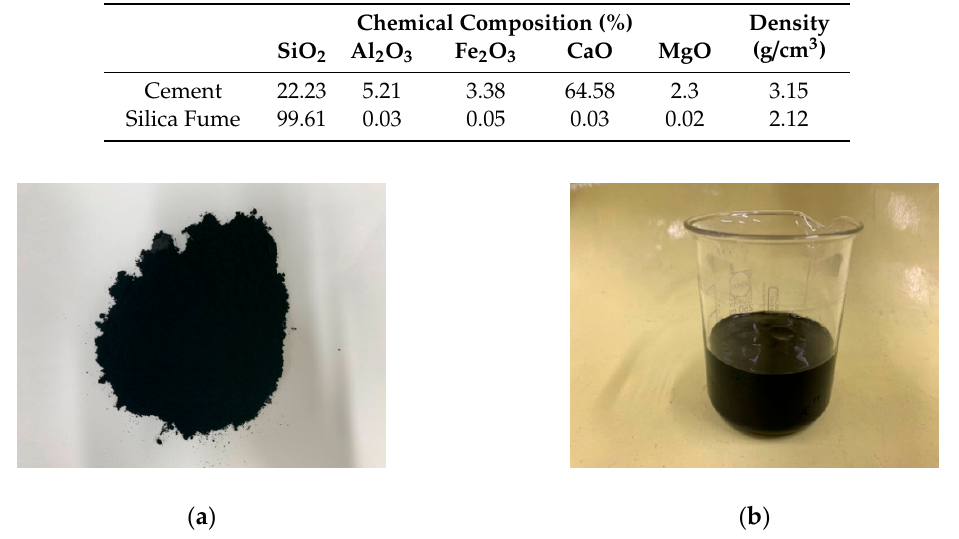
Figure 1. Pictures of ( a ) powder type and ( b ) liquid type multi-wall carbon nanotubes. Table 2. Composition of liquid multi-wall carbon nanotubes (MWCNTs) (mass fraction). Table 1. Chemical compositions and densities of cement and silica fume.